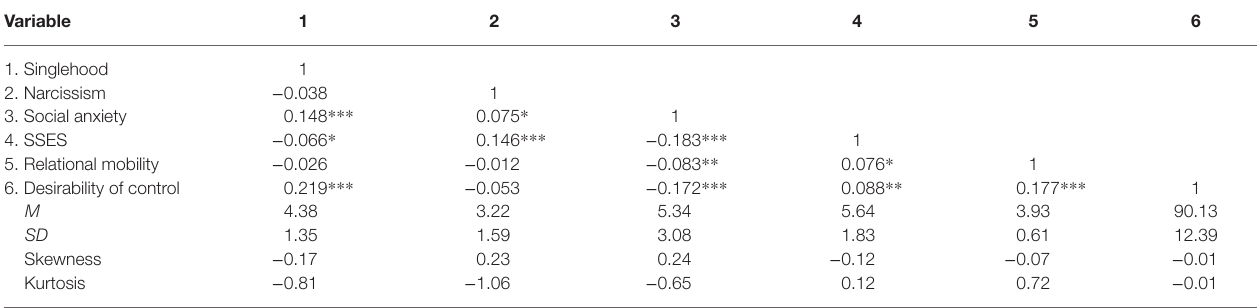
TABLE 1 | Descriptive statistics and correlations for study variables. Variable